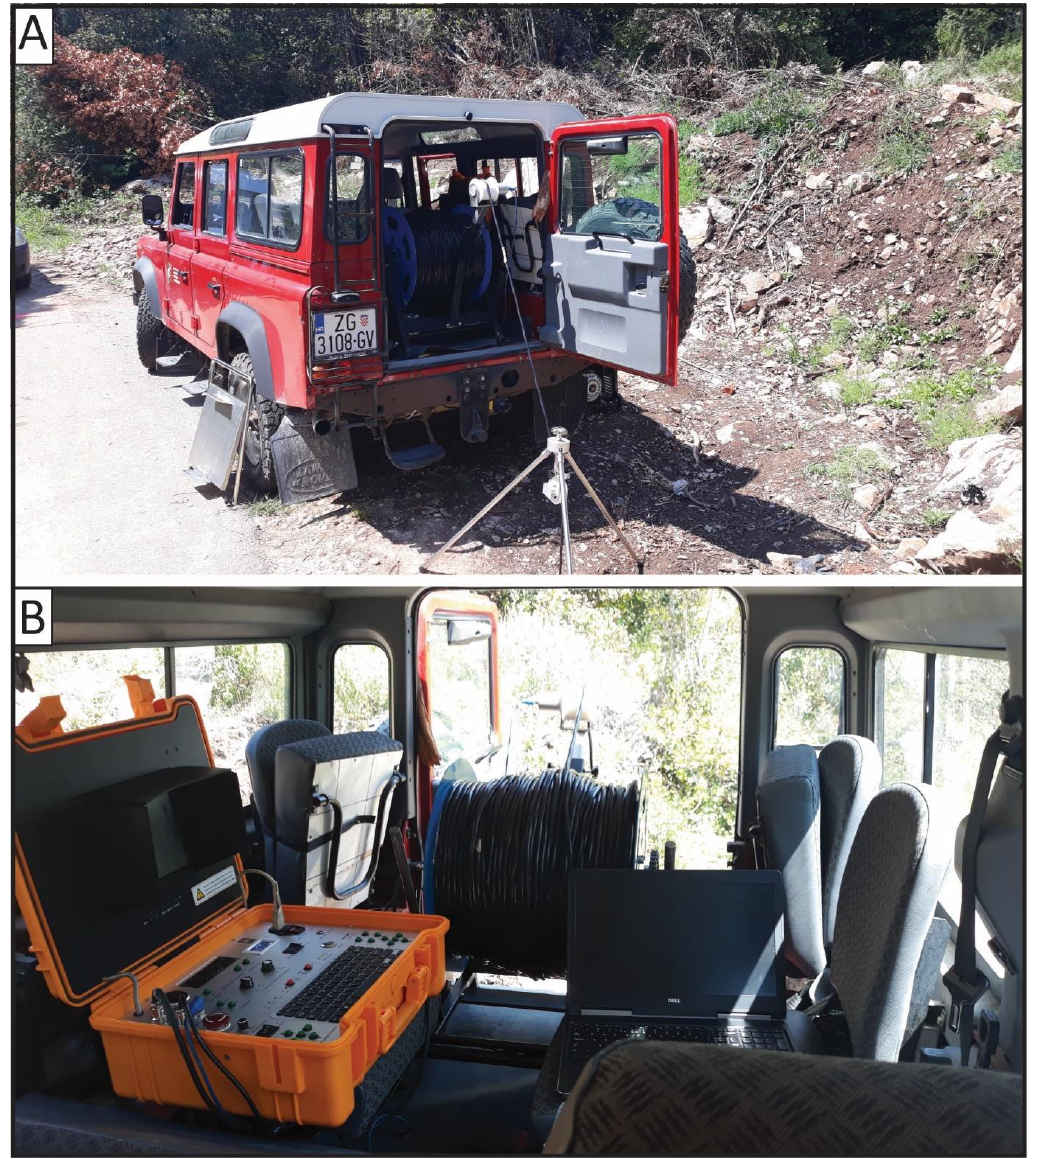
Figure 5. Borehole camera fieldwork configuration. ( A ) Terrain vehicle and tripod for centering of borehole camera; ( B ) operation console and winch for borehole camera.